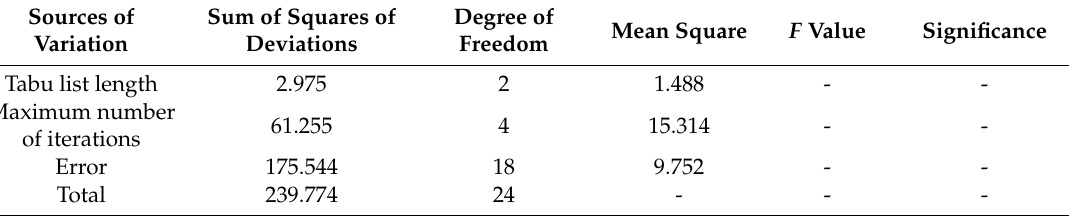
Table A3. Analysis of variance table of the NTS